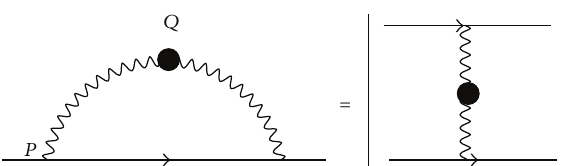
Figure 1: Fermion self-energy with resummed photon